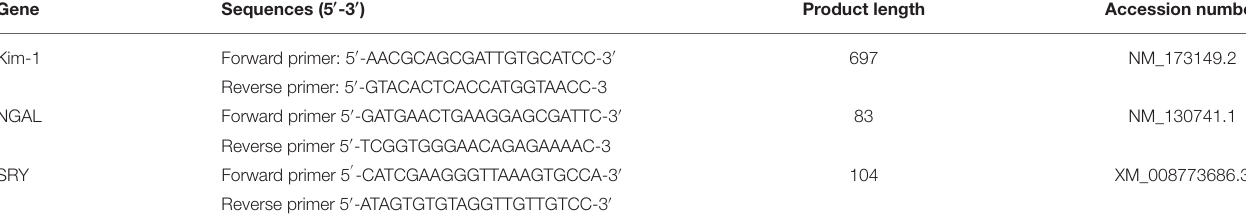
TABLE 1 | The primer sequences for real-time PCR assay.